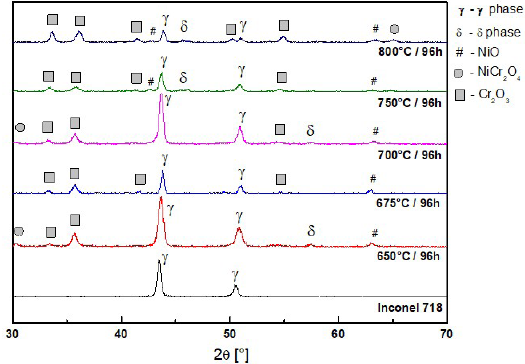
Figure 4. Patterns of X-ray diffraction of Inconel 718 as received and oxidized at different temperatures.